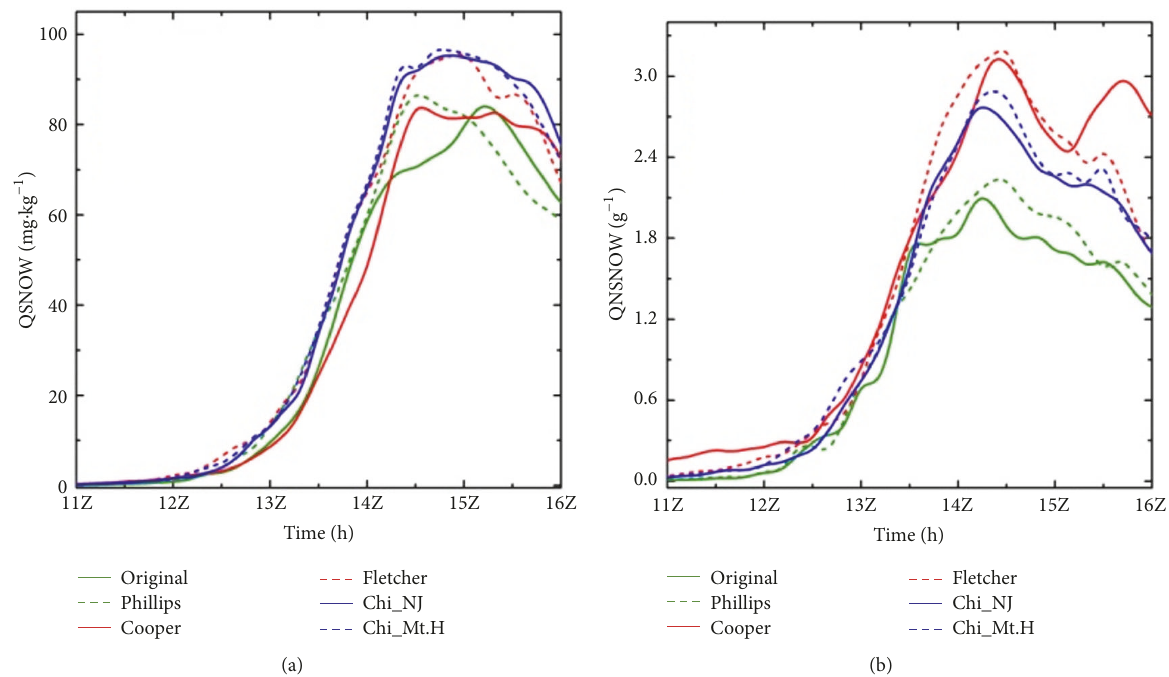
Figure 8: Variation of the regional average (118.7 ∘ E–120.2 ∘ E, 29.4 ∘ N–30.4 ∘ N) mixing ratio ((a) unit: mg ⋅ kg −1 ) and concentration ((b) unit: 10 3 L −1 ) of snow particles with